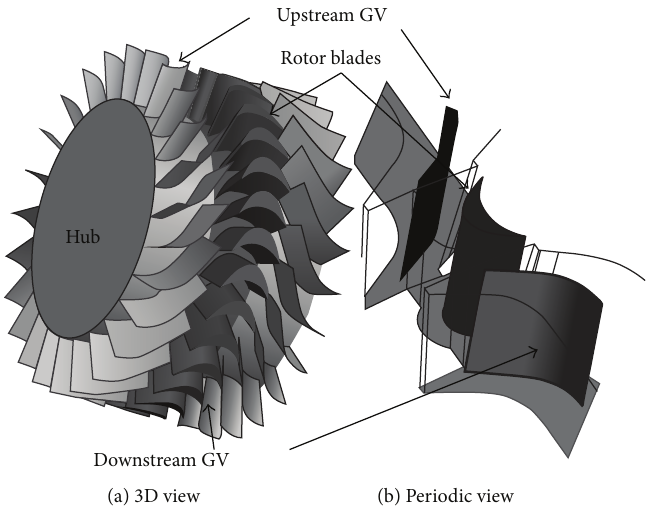
Figure 1: Impulse turbine. Table 1: Design specifications of rotor and guide